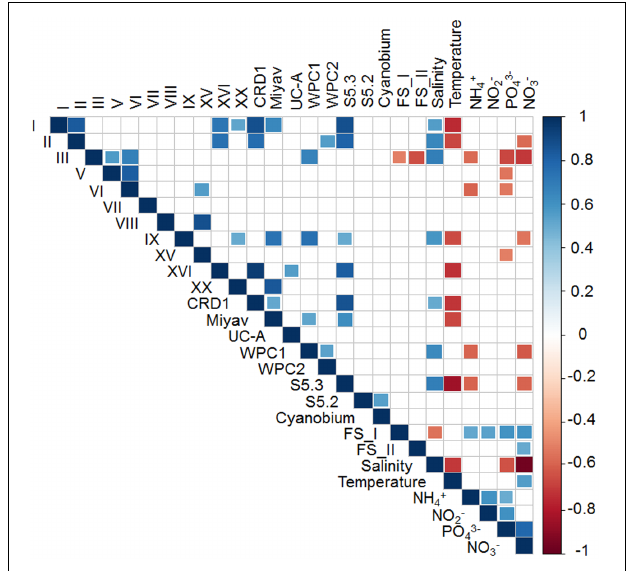
FIGURE 5 | Spearman rank correlation between Synechococcus clades and environmental factors. Only significant correlations ( P < 0.05) are